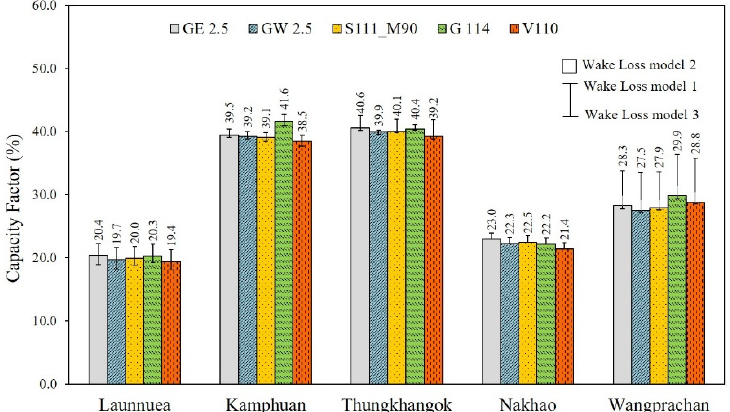
Figure 12. Estimated annual energy productions of 10-MW VSPP wind power plants at the potential sites of development.